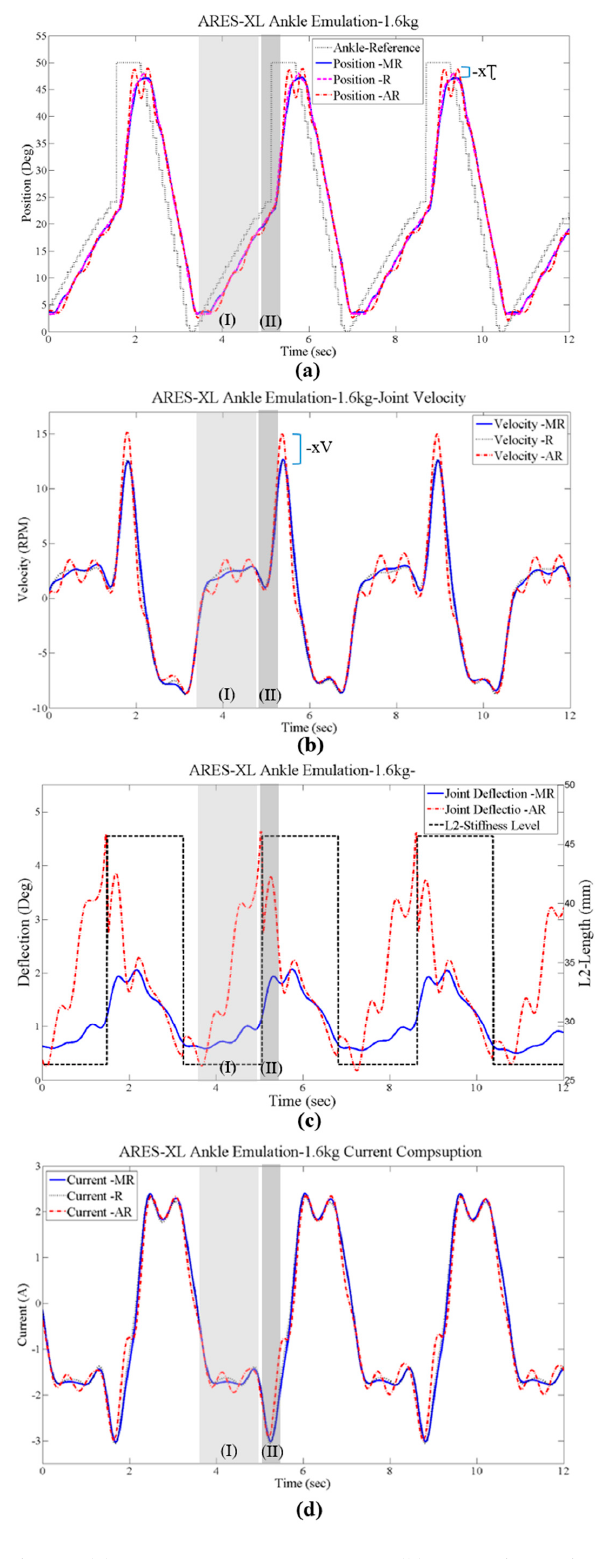
Figure 10. Ankle emulation: ( a ) ARES-XL position response; ( b ) joint velocity during trials; ( c ) stiffness levels–state machine, and joint deflections; ( d ) current consumption in the tested cases.